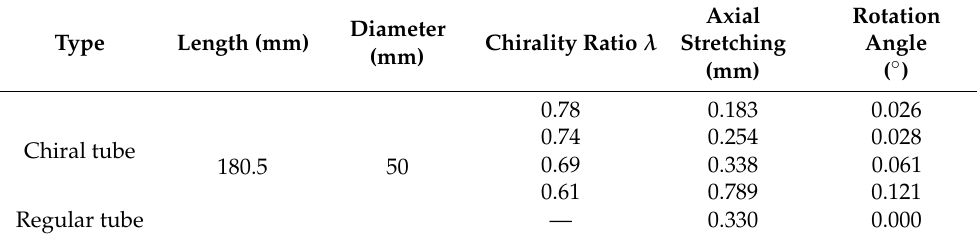
Figure 5. ( a ) The axial stretching and rotation angle vary with the chiral ratio. ( b ) Comparison between the chiral tube and the regular tube. Table 3. The elongation and rotation angle of the chiral and regular